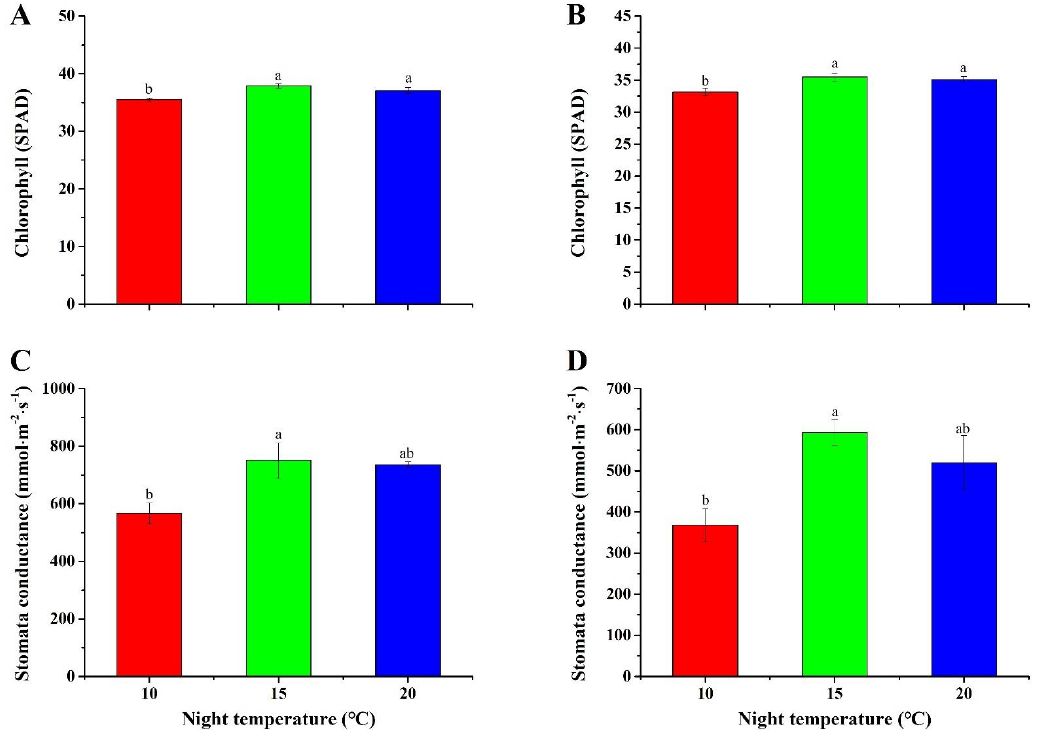
Figure 4. Effect of night temperature on the chlorophyll content and stomatal conductance in plug seedlings of A. membranaceus ( A and C ) and C. lanceolata ( B and D ). Data are presented as the mean ± standard error (n = 3). Different letters (a and b) indicate significant differences among treatments by Duncan’s multiple range test at a 0.05 level.